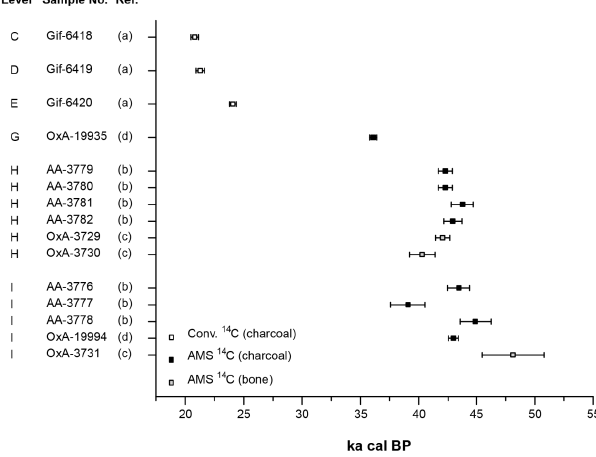
Figure 11: 95.4%-probability interval of calibrated 14 C-ages of charcoal and bone samples 2 Figure 11. 95.4% probability interval of calibrated 14 C ages of after (a) Delibrias et al (1987), (b) Bischoff et al. 1989, (c) Maroto et al. (1996) and (d) 3 charcoal and bone samples after (a) Delibrias et al. (1987), (b) Maroto et al. (2012). The laboratory protocols used by Maroto et al. (2012) include rigorous 4 Bischoff et al., 1989, (c) Maroto et al. (1996) and (d) Maroto sample pre-treatment to minimize contamination of samples. For calibration the CalPal-2007-5 et al. (2012). The laboratory protocols used by Maroto et al. (2012) Hulu dataset (Weninger and Jöris, 2008) and the CalPal software package (Weninger et al. 6 include rigorous sample pre-treatment to minimize contamina- 2008) were used. 7 tion of samples. For calibration the CalPal-2007-Hulu data set (Weninger and Jöris, 2008) and the CalPal software package (Weninger et al., 2008) were